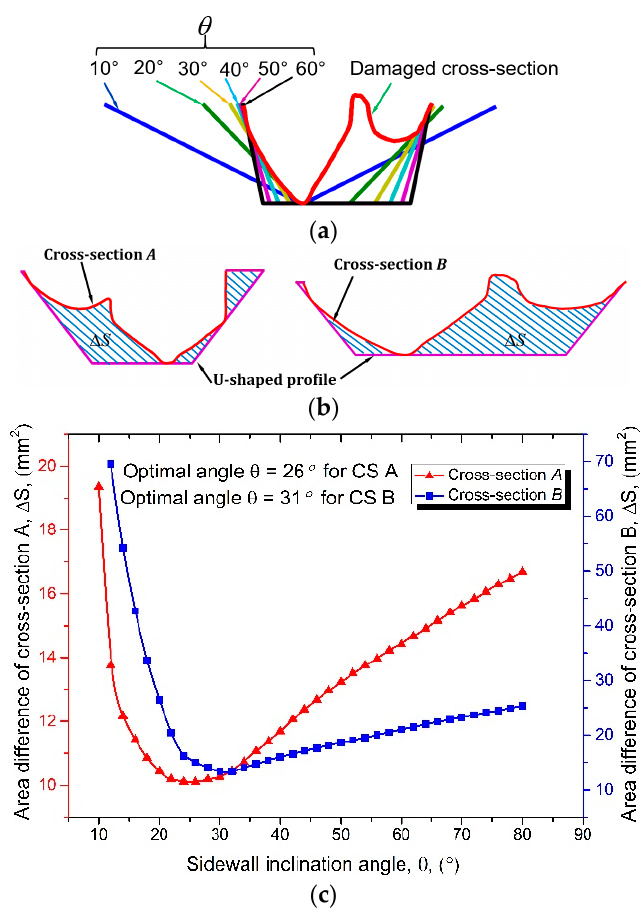
Figure 7. Sidewall inclination angle optimization for UB. ( a ) UB with varied approaching lines; ( b ) UB for cross-sections A and B ; ( c ) relationship between area difference ∆ S and inclination angle θ . CHB Definition